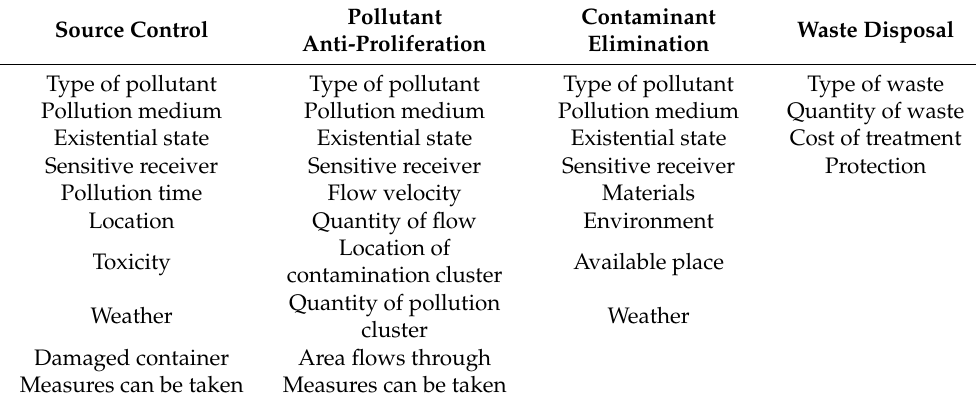
Table 1. Evaluation index system of each